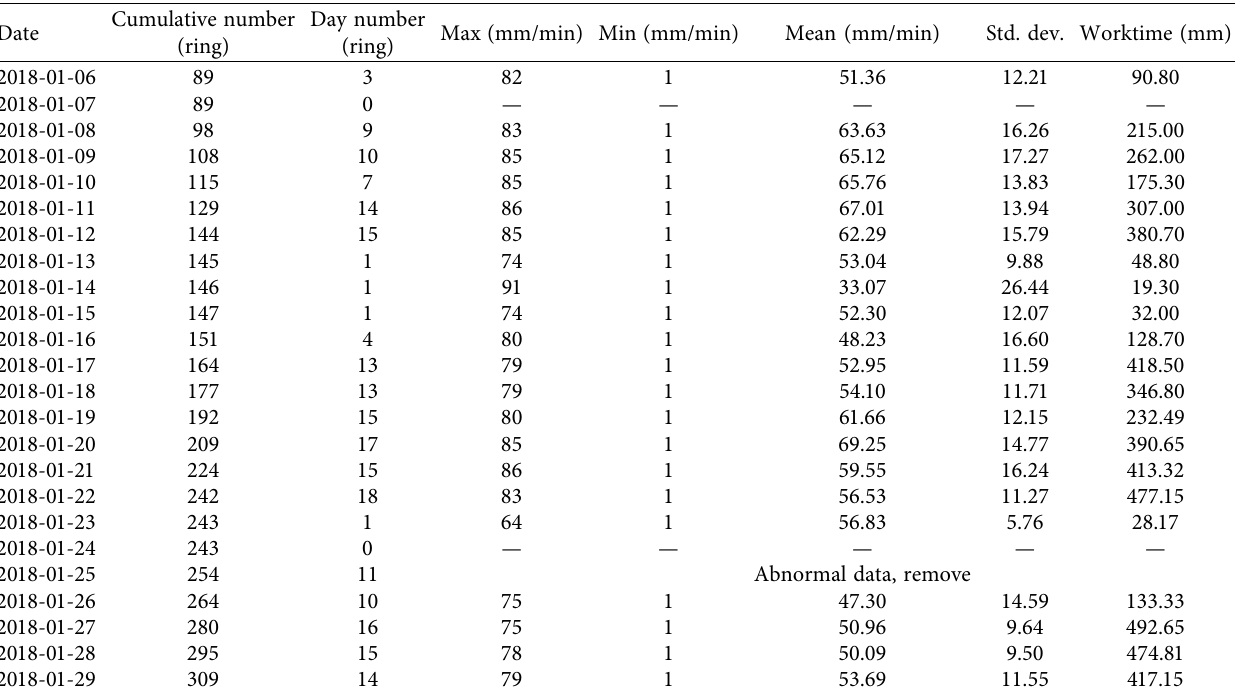
Table 6: Comparison of measured and predicted